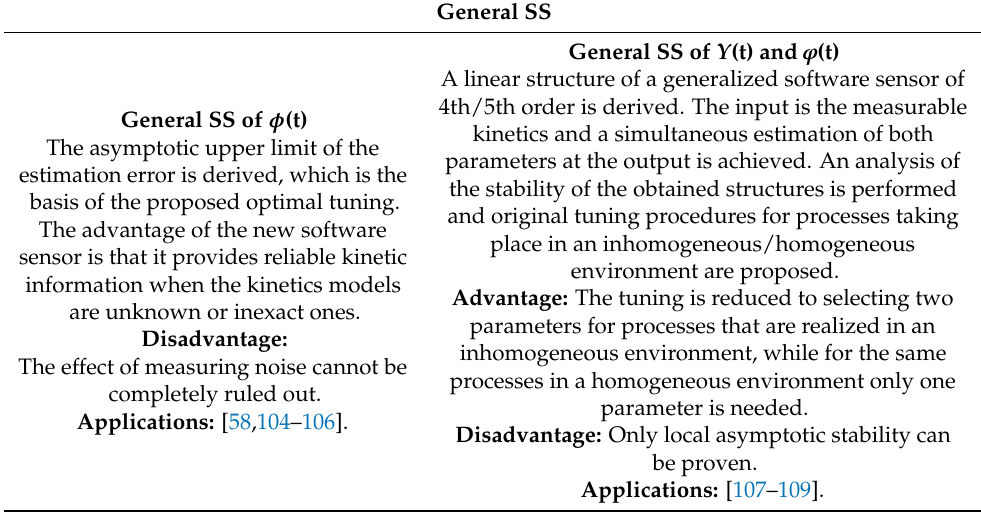
Table 7. General SS based on the new formalizations from Table